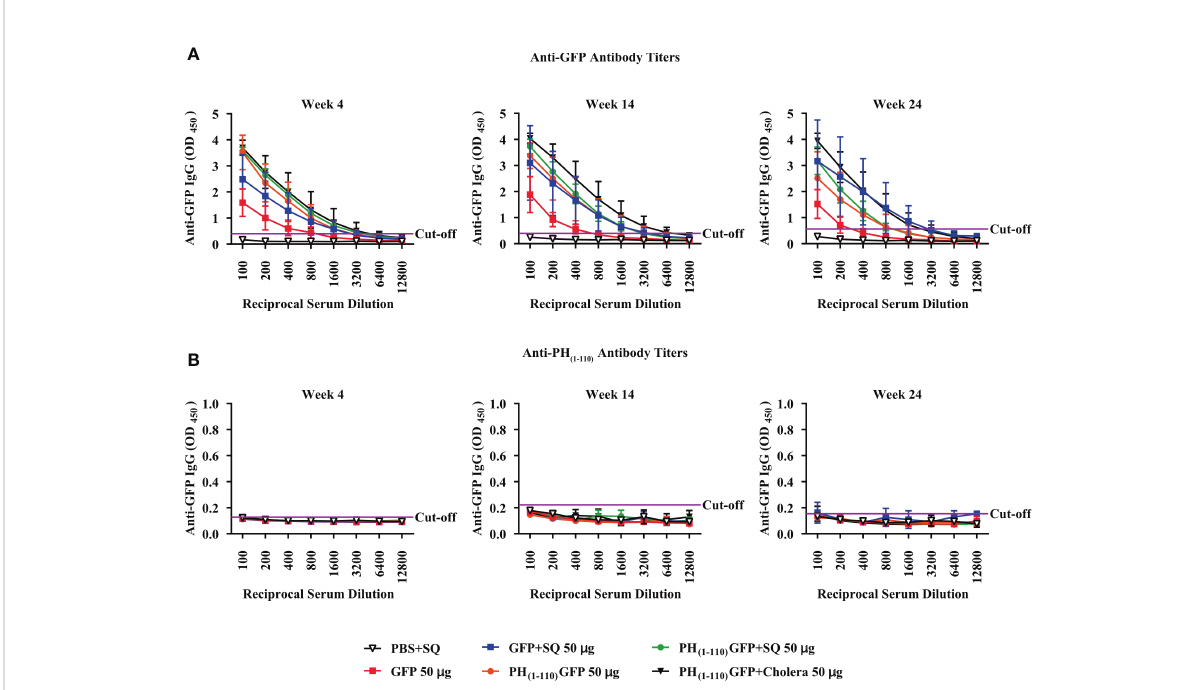
FIGURE 4 Production of high titers of speci fi c antibodies against the GFP antigen and not against the nano-carrier PH (1-110) . Serial 2-fold dilution of sera from immunized mice to determine the titers of speci fi c antibodies against GFP (A) and against PH (1-110) (B) ; for both the titers were determined at week 4, 14, and 24. The horizontal purple line shows the cut-off point. Data represent mean ± SD (n =